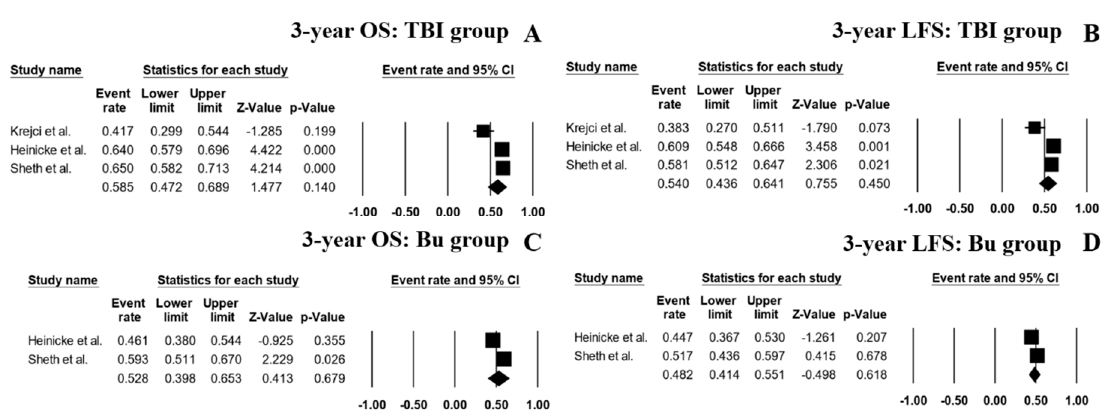
Figure 6. Forest plots of pooled estimates ( 95 % CI ) for outcome outcomes of the patient ’ s subgroups; ( A ) : 3 - year OS of patients receiving total body irradiation (TBI) - based conditioning regimen; ( B ) : 3 - year LFS of patients receiving TBI - based conditioning regimen; ( C ) : 3 - year OS of patients receiving busulfan - based conditioning regimen; ( D ) : 3 - year LFS of patients receiving busulfan - based conditioning regimen.